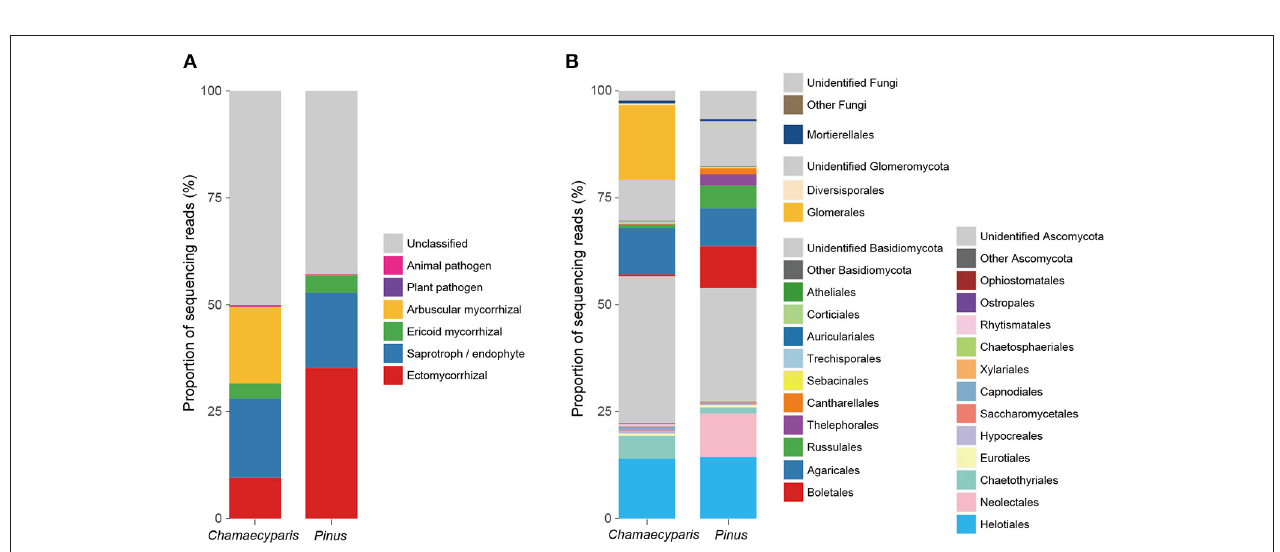
FIGURE 2 | Compositions of the fungal community. (A) Functional groups (category). Average proportions of sequencing reads were calculated for Chamaecyparis and Pinus root samples. (B) Order-level